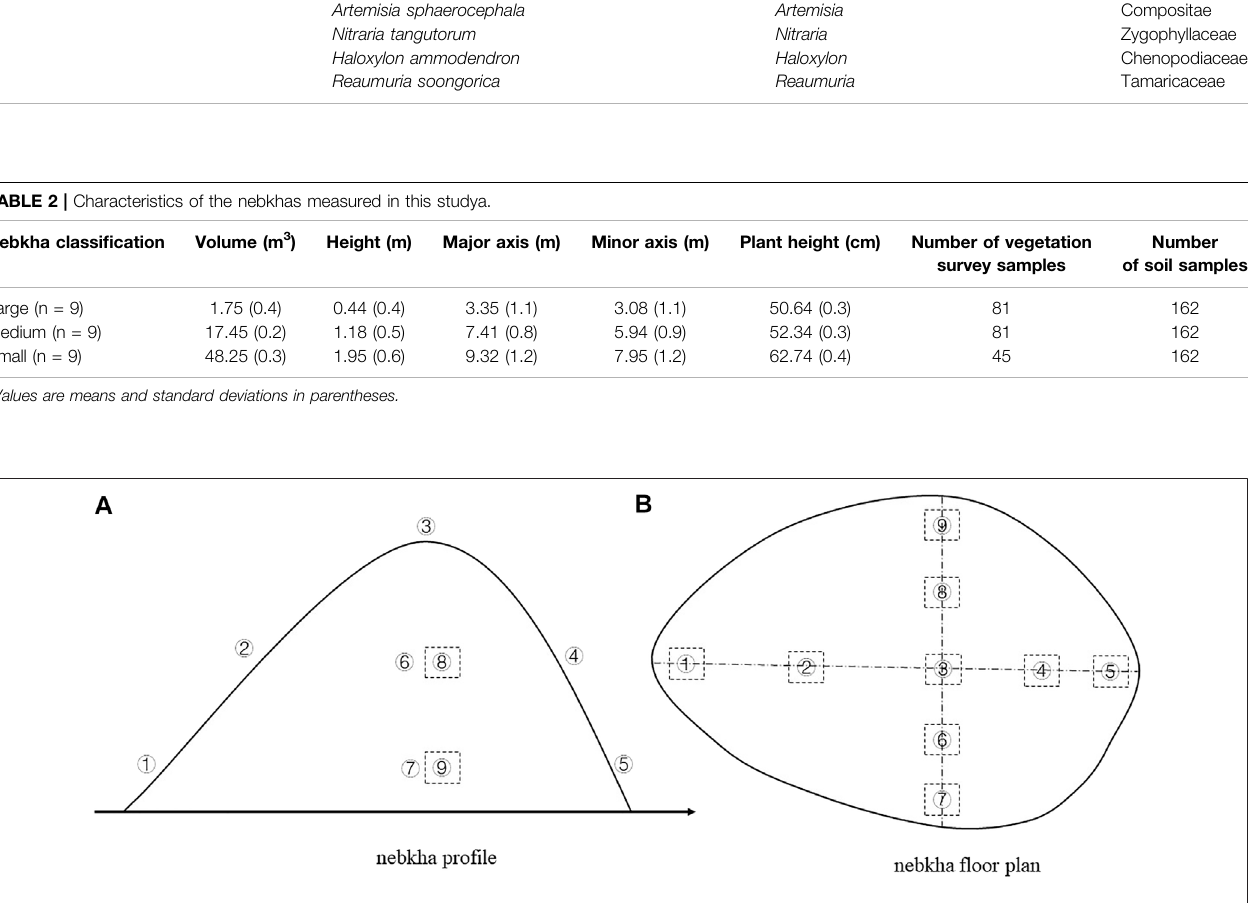
FIGURE 1 | Schematic diagram of sampling sites in Nitraria tangutorum nebkhas. ① West bottom, ② West middle, ③ Top, ④ East middle, ⑤ East bottom, ⑥ South middle, ⑦ South bottom, ⑧ North middle, ⑨ North bottom.